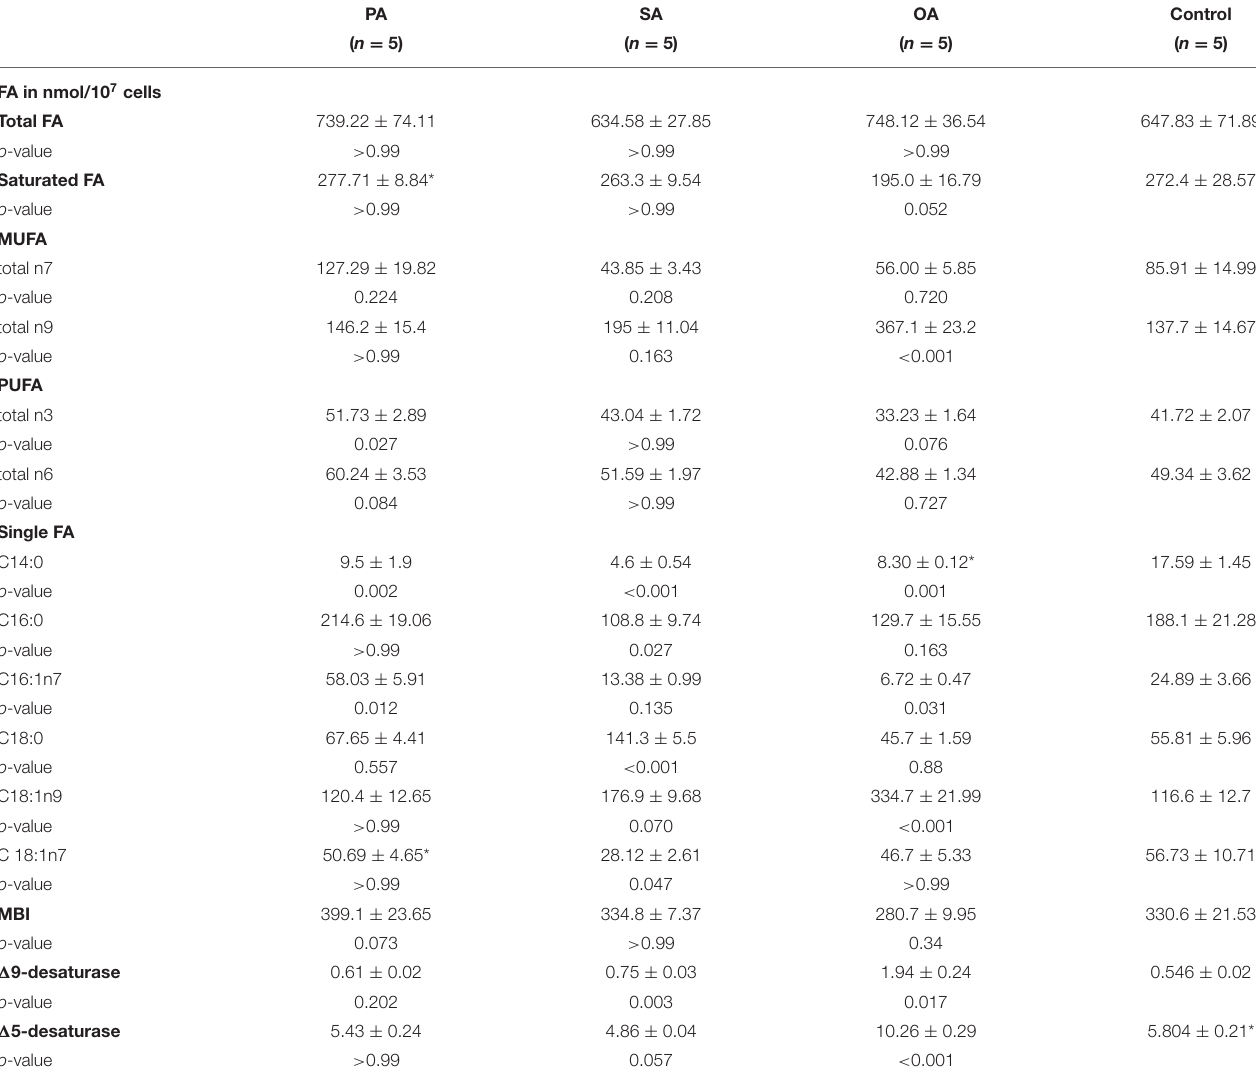
TABLE 3 | Fatty acid pattern of